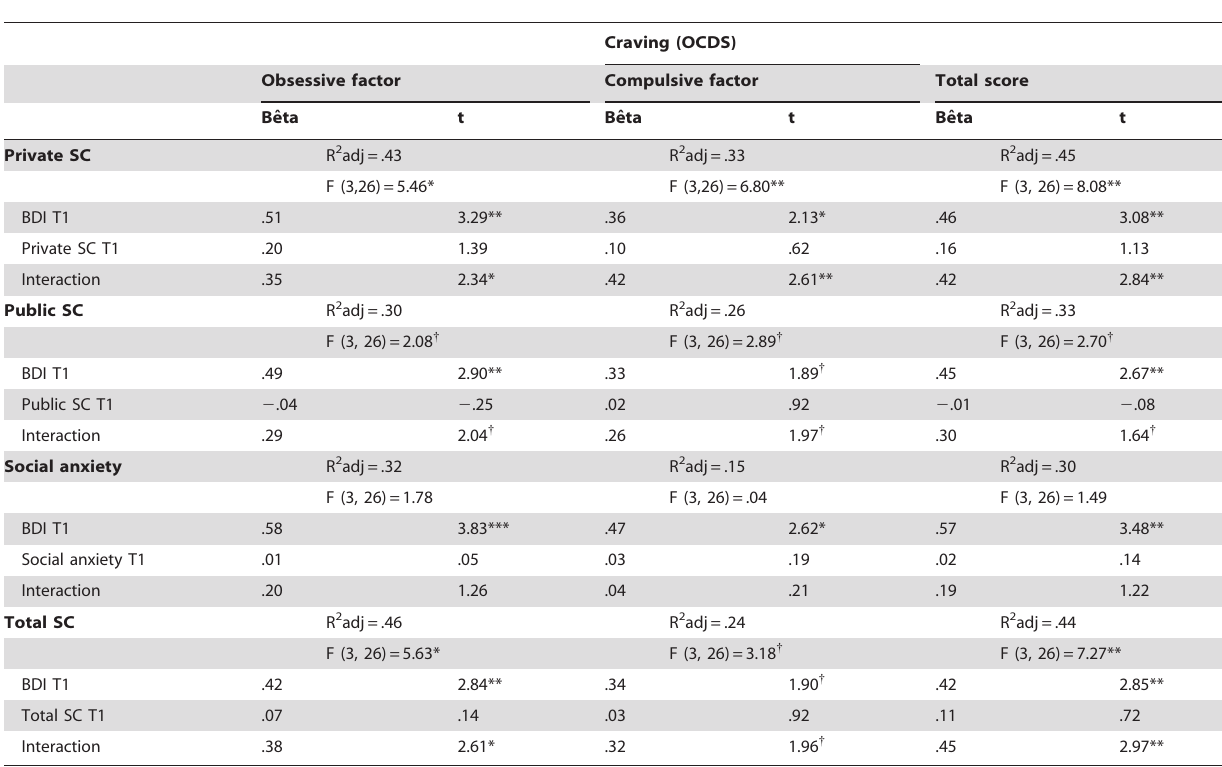
Table 2. Multiple regression analyses predicting craving scores (T1) as a function of depression T1, SC T1 and their